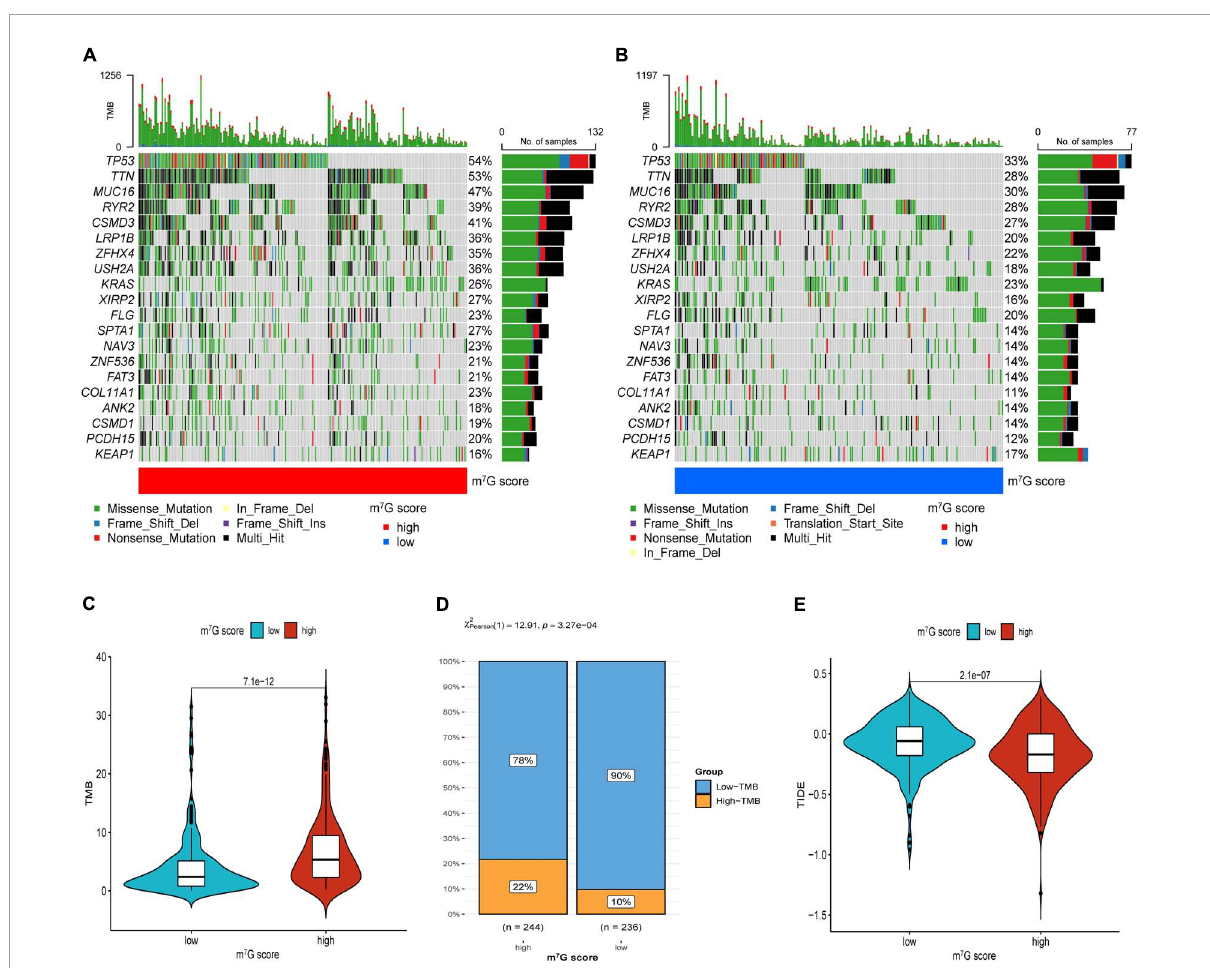
FIGURE12 Immunotherapeutic response evaluation in high and low m 7 G score groups. (A) Mutation plot in high m 7 G score group. (B) Mutation plot in low m 7 G score group. (C) Results of TMB between two groups. (D) Distribution of low and high TMB between two subtypes. (E) Results of TIDE between two